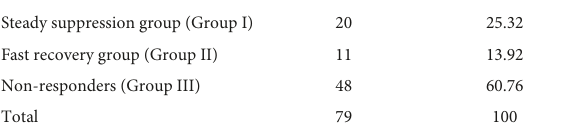
TABLE 3 Division into groups.